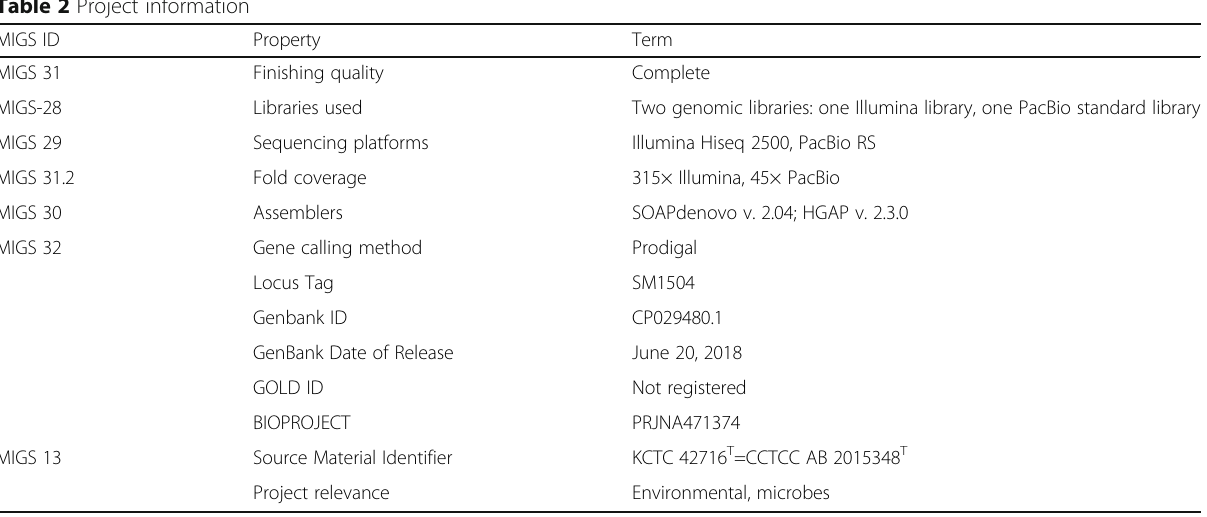
Table 2 Project